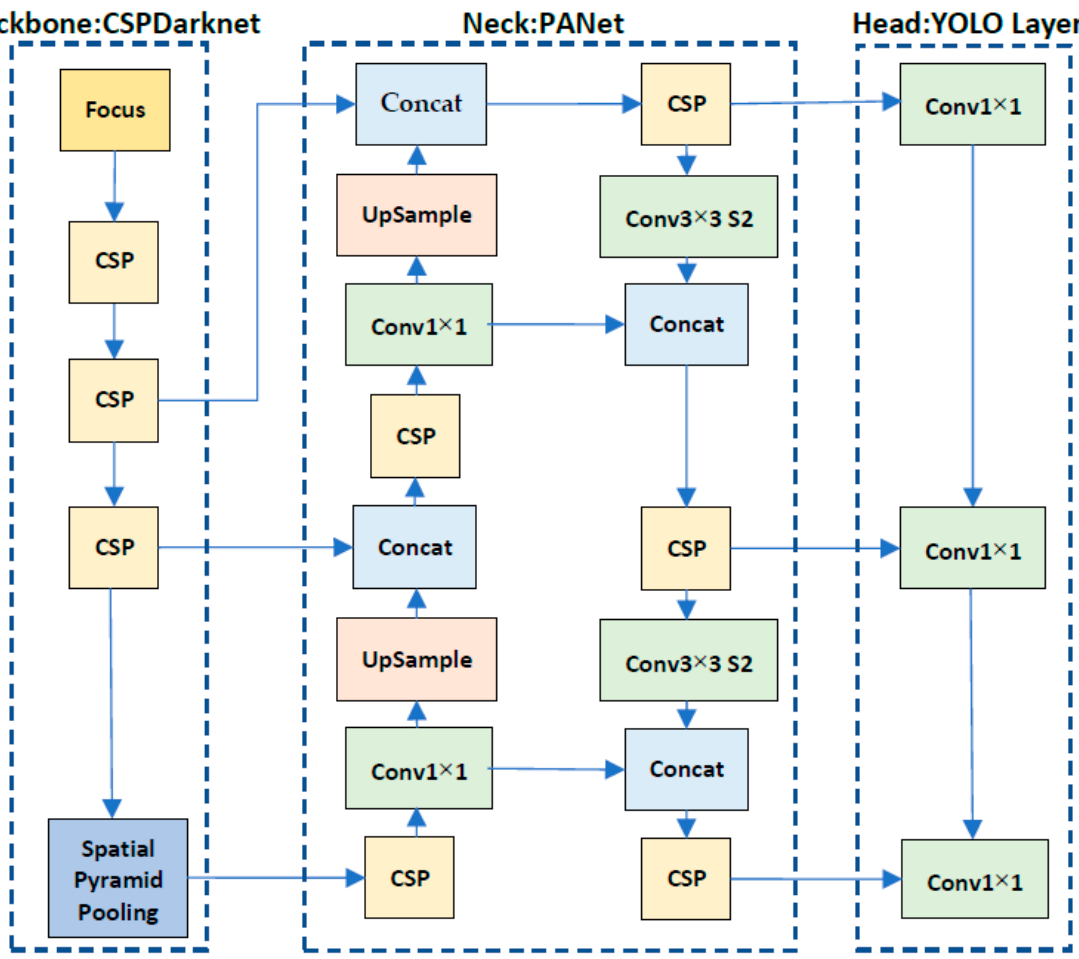
Figure 7. Network architecture of YOLOv5 with three stages: the backbone for feature extraction, the neck for feature fusion, and the head for object prediction.